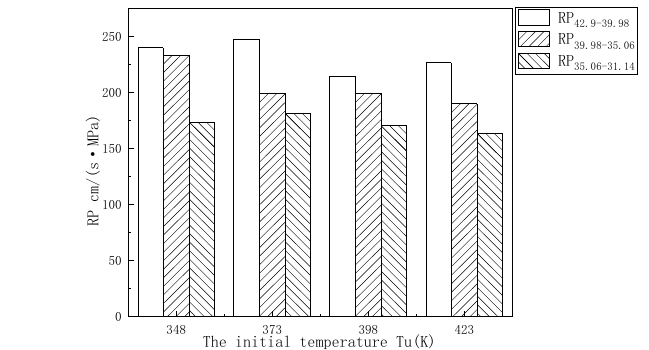
Figure 14. Equivalent variation in u L corresponding to the initial condition change with Tu.